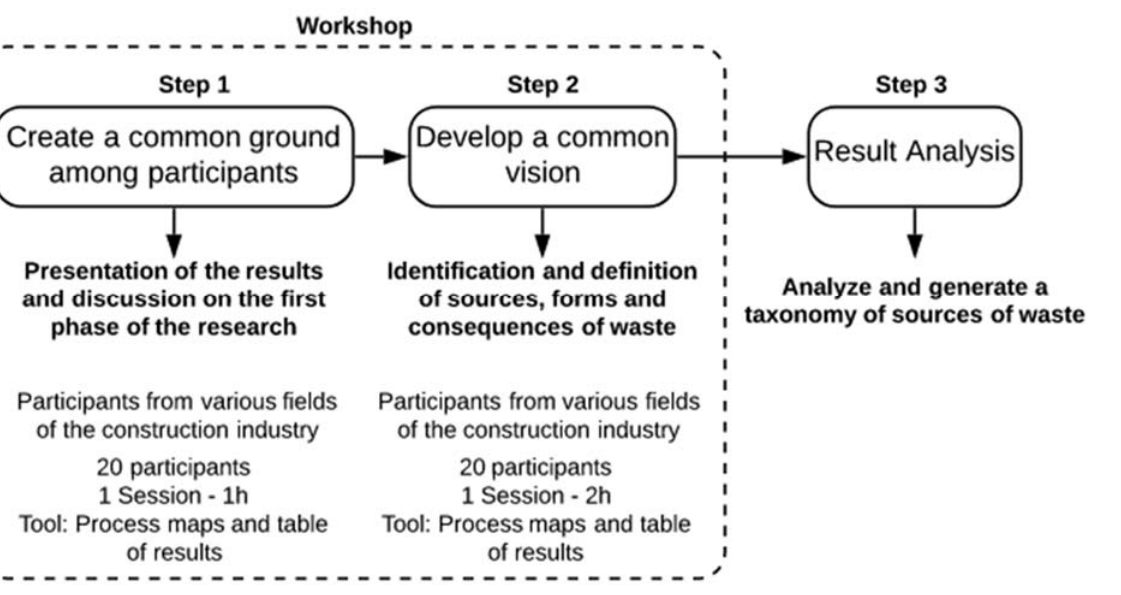
Figure 2. Steps of the ShareLab approach.